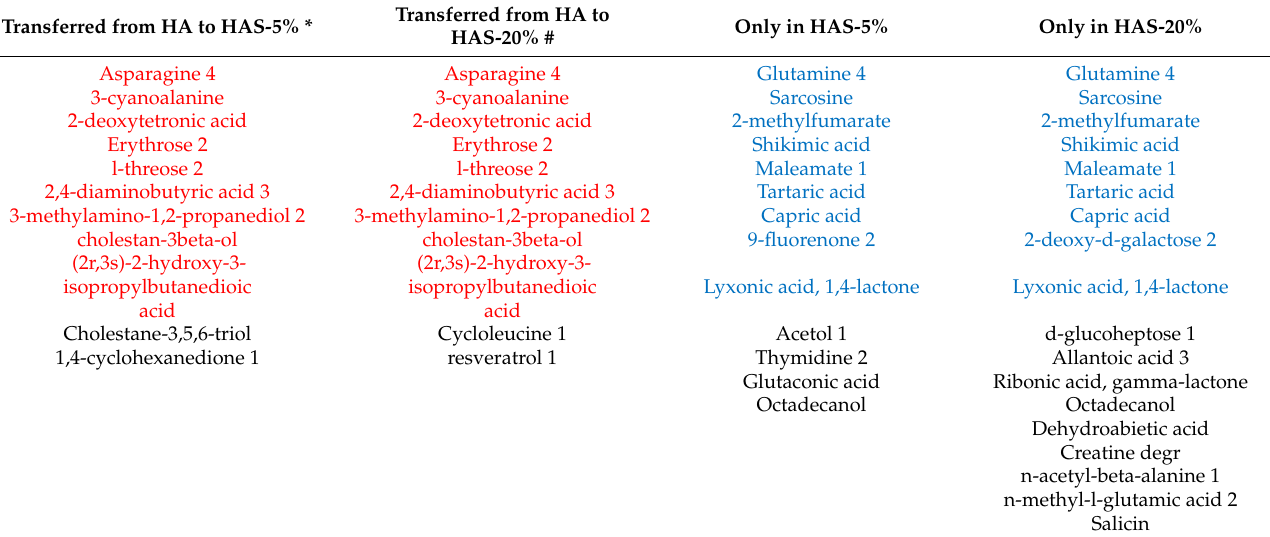
Table 2. Differential expression of metabolites in HA, S, HAS-5% and